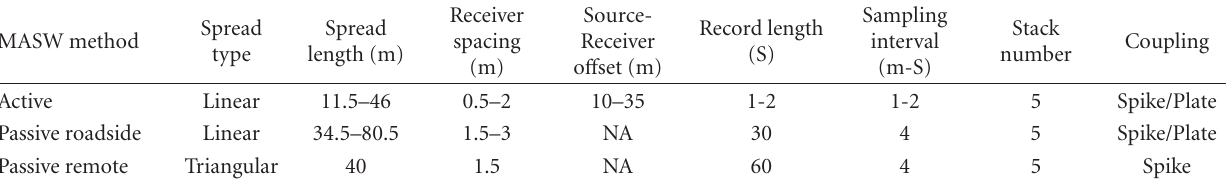
Table 1: Main field parameters for di ff erent MASW tests.